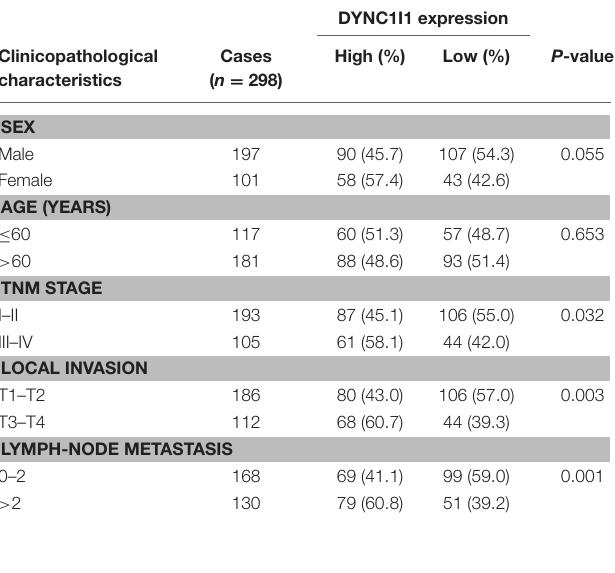
TABLE 1 | DYNC1I1 expression and clinicopathological characteristics in 298 gastric cancer.